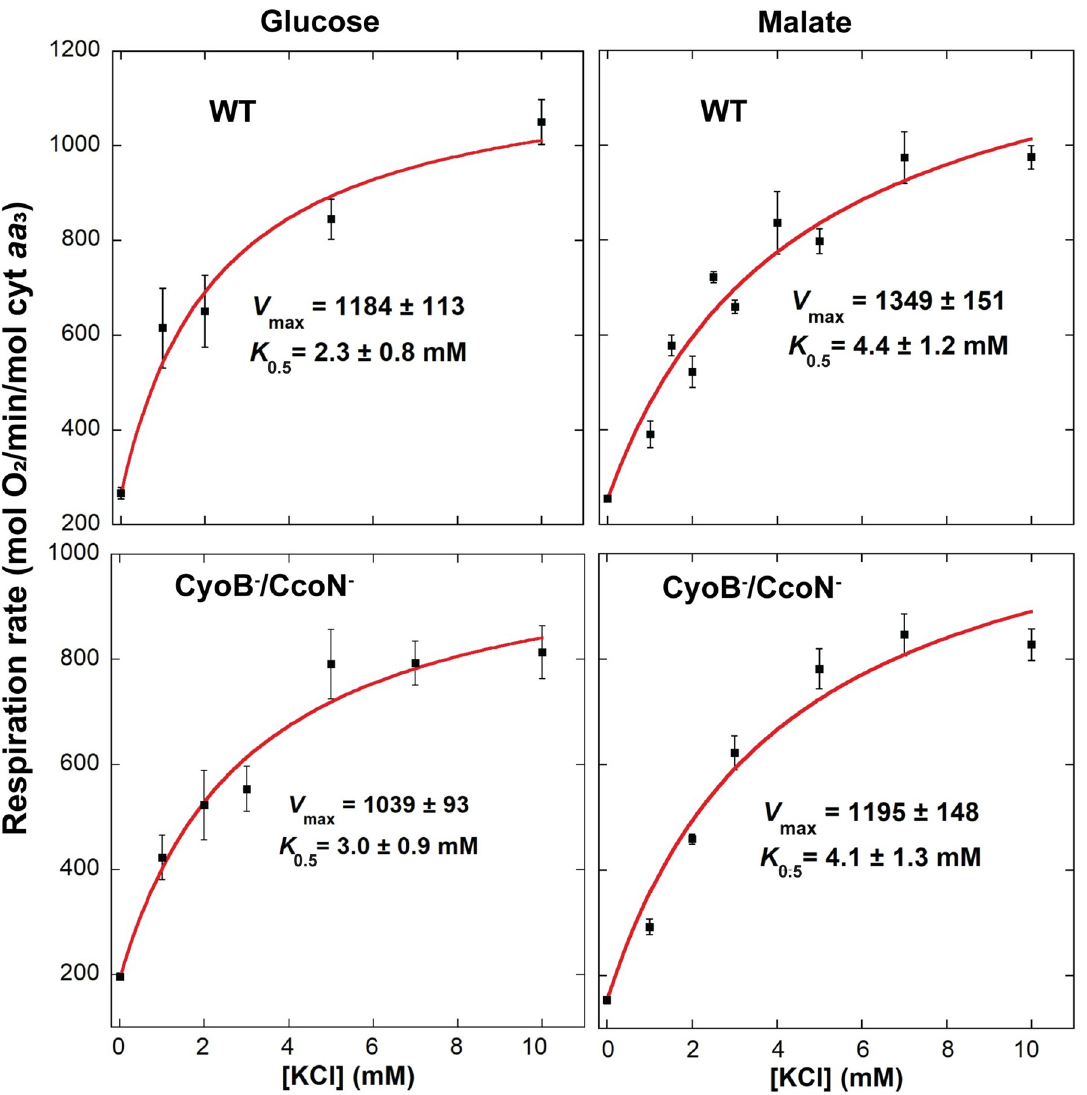
Fig 4. Dependence of respiration rate on the concentration of KCl in wild-type (top) and CyoB - /CcoN - (bottom) cells adapted to growth in glucose (left) or malate (right). V max and K 0.5 values were calculated by fitting the average respiration at each KCl concentration to a Michaelis-Menten equation with an added offset to account for the respiration observed without KCl present. Error bars correspond to the standard error of 3–8 independent determinations at each KCl concentration, except for 0 mM (n = 27–68) and 10 mM, for which the number of measurements was the same as shown in Table